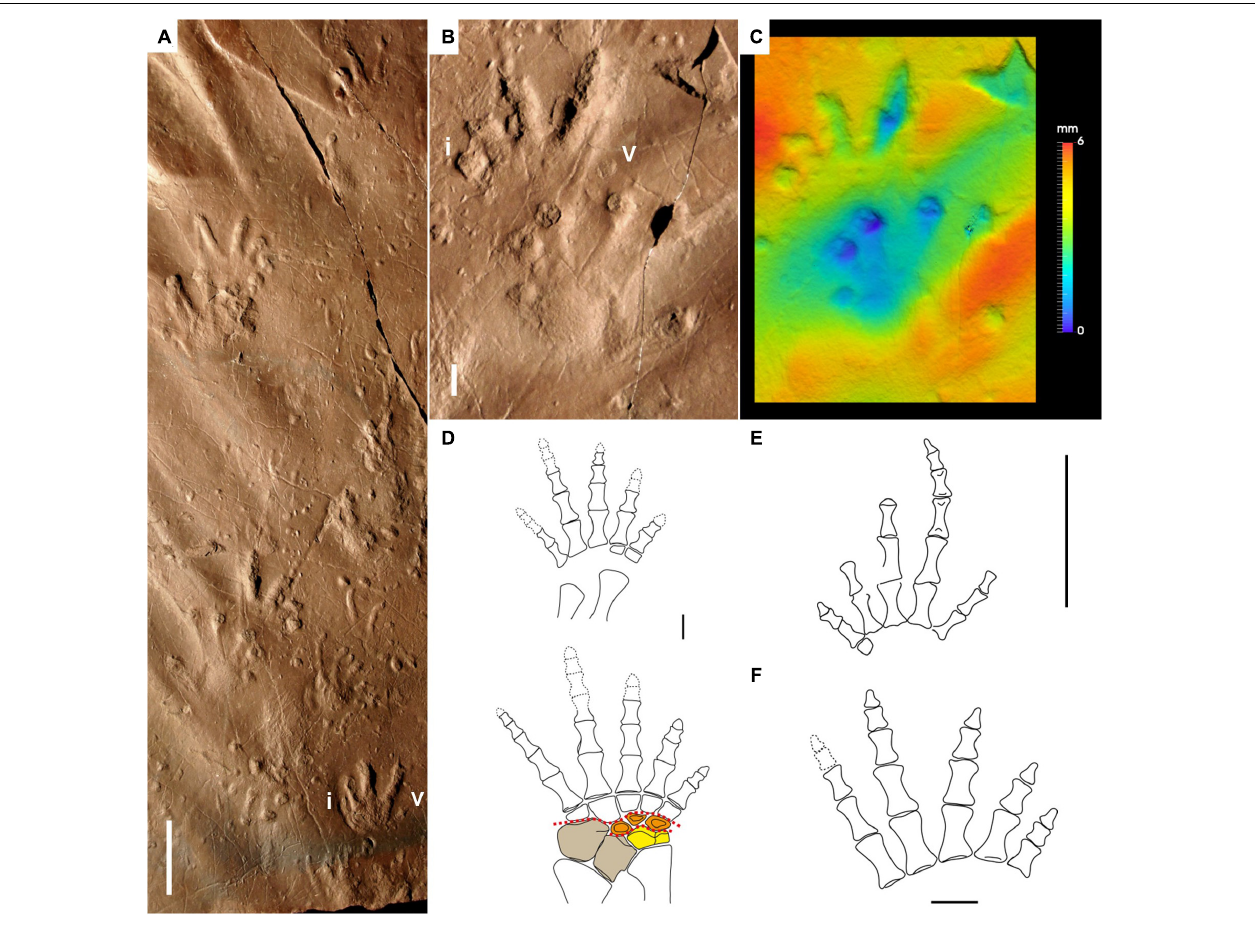
FIGURE 5 | Carboniferous anamniote reptiliomorph tracks and trackmakers: Hylopus hardingi (A–C) and stem tetrapods and anthracosaurids (D–F) . (A) NMMNH P-64276, trackway, convex hyporelief. Mauch Chunk Formation, Pennsylvania. (B) NMMNH P-64276, right pes-manus couple, concave epirelief. (C) False-color depth map of (B) . (D) Proterogyrinus scheelei , reconstruction of left pes and manus, dorsal side. From Holmes (1984), modified. Manual digits indicated by Roman numbers. Centralia in orange, tibiale in yellow and intermedium and fibulare in brown. Red dotted lines represent the possible articulations within the tarsus. (E) Casineria kiddi , reconstruction of right manus, dorsal side. From Paton et al. (1999), modified. (F) Greererpeton burkemorani , reconstruction of left pes, dorsal side. From Clack (2002), modified. Scale bar (A) is 5 cm, scale bars (B,D–F) are 1